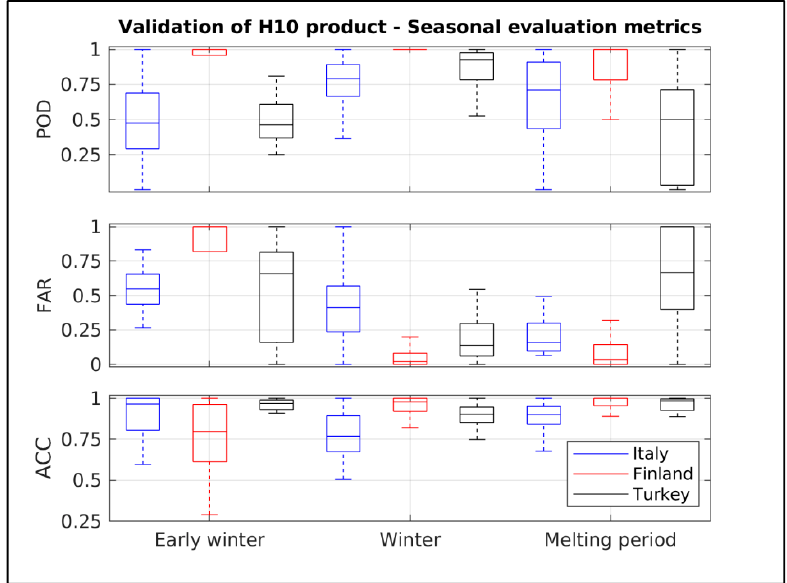
Figure 15. Evaluation metrics at tile scale in Turkey.